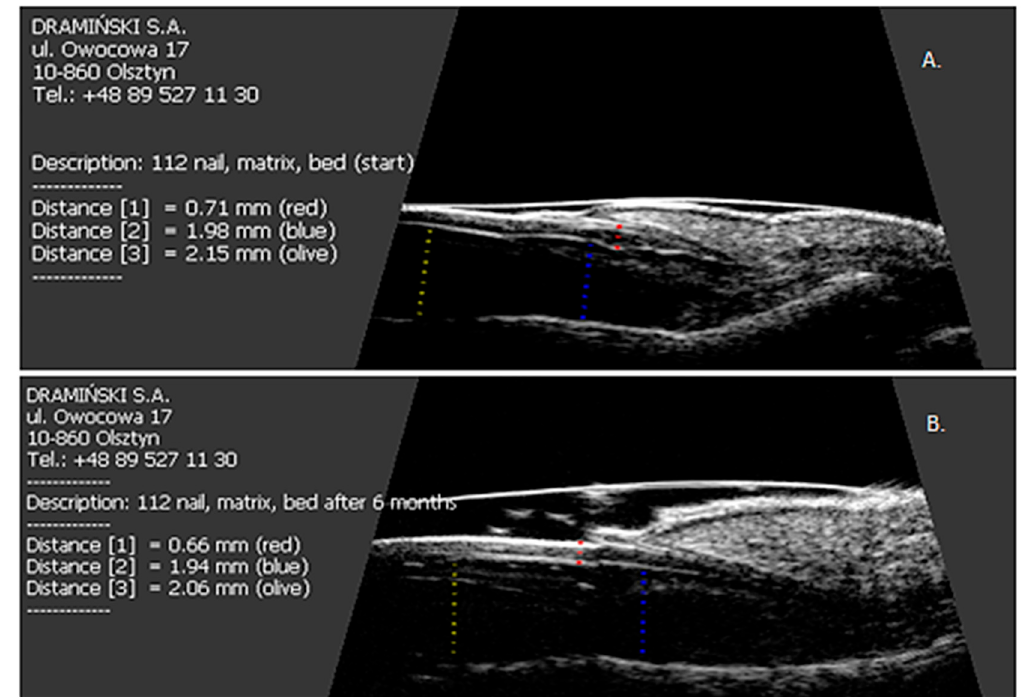
Figure 3. The effect of six months of methotrexate treatment on the thickness of the nail plate, nail bed and nail matrix in patients studied. ( A ) Before treatment; ( B ) after six months of therapy.